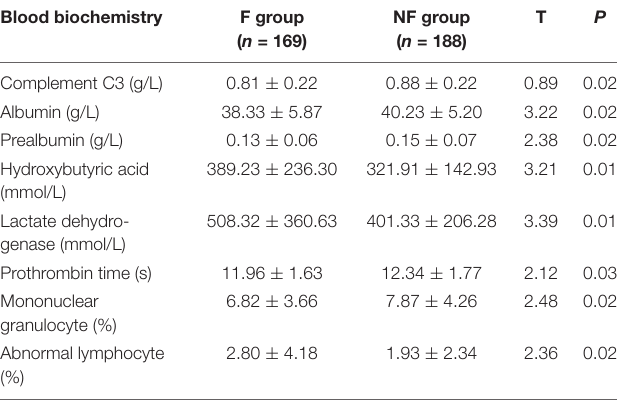
TABLE 6 | Comparison of the routine blood test between groups.